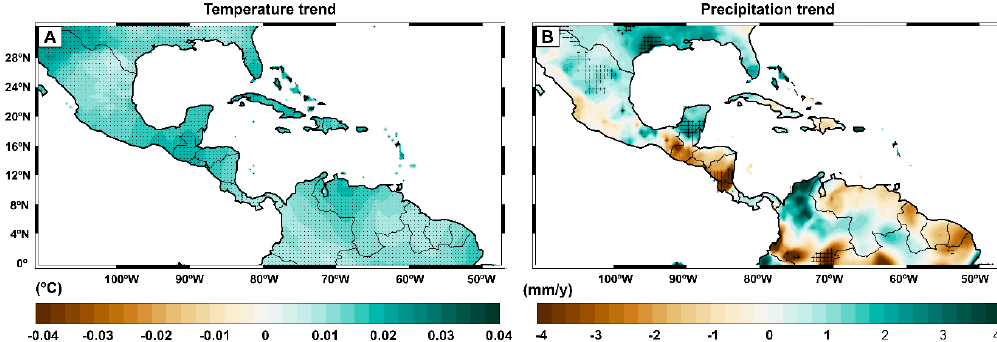
Figure 8. Long–term trends between 1950 and 2019 for ( A ) temperature based on the Climatic Research Unit gridded Time Series (CRU TS) v4.04, and ( B ) rainfall based on ERA–5. Dots represent statistically significant trends at p < 0.05.